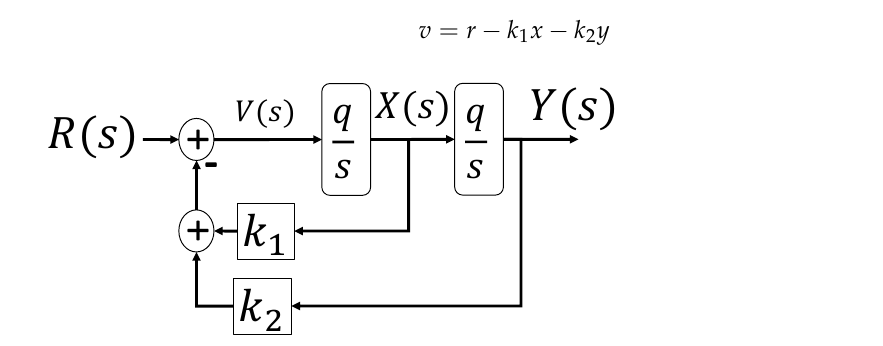
Figure 12. Block diagram representation of a static state feedback controller stabilising a double- integrator